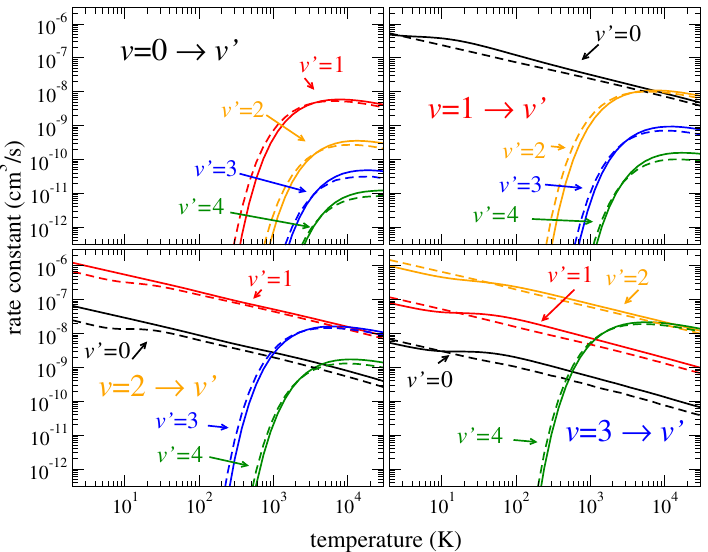
Figure 3. Same as Figure 2 for 3 HeH + (solid lines) and 3 HeD + (dashed